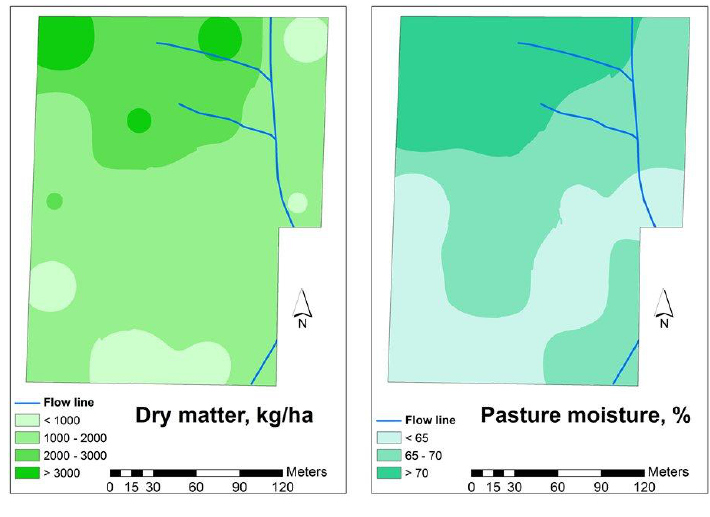
Figure 10. Pasture dry matter yield and pasture moisture content in February of 2012 in the experimental